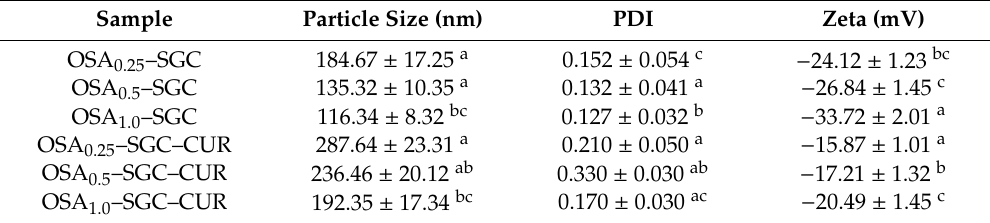
Table 4. The particle size and the polydispersity coe ffi cient (PDI) of OSA–SGC–CUR